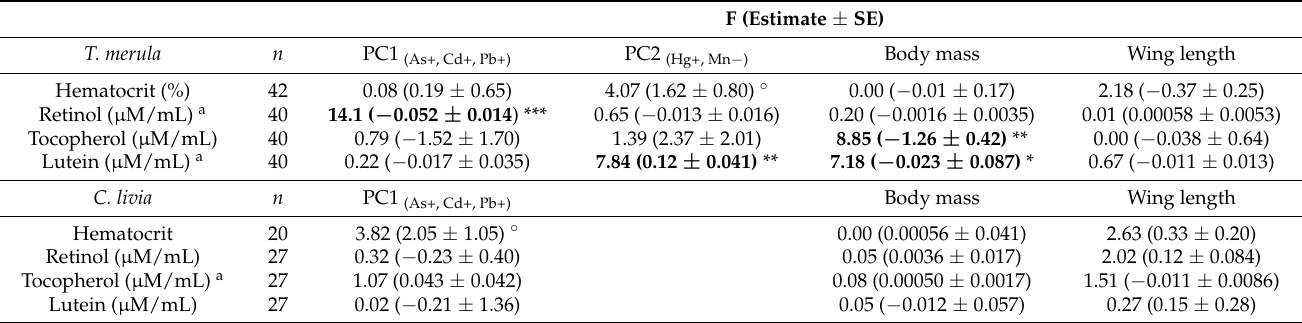
Table 3. Linear models for explaining variation in hematocrit value and the biochemical plasma variables of Turdus merula and Columba livia . Principal components (PC1 and PC2) describe variations in the concentration of major toxic metals in blood (see methods). Statistically significant effects are shown in bold.